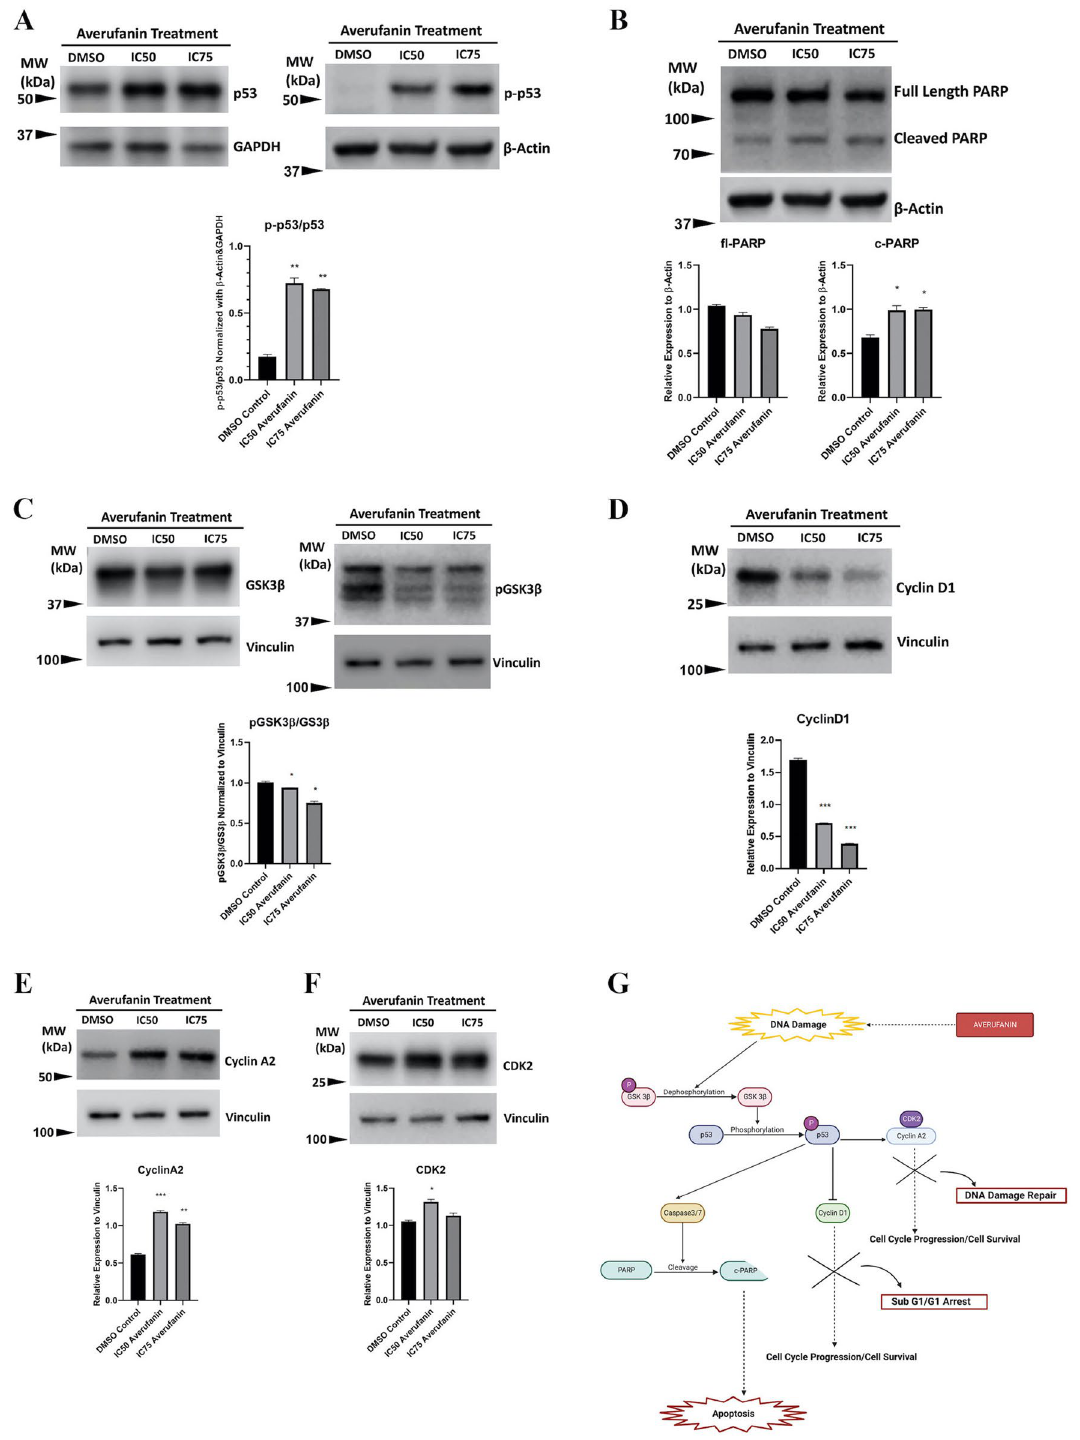
Figure 7. Cellular pathway components targeted by Averufanin treatment. Human breast cancer cells (T47D) were treated with the IC 50 and IC 75 concentrations of Averufanin or DMSO control for 48 h. ( A ) Western blot analysis showed that p53 protein was activated by phosphorylation upon treatment with Averufanin. Furthermore, ( B ) PARP protein was shown to be cleaved indicating induction of apoptosis. ( C ) pGSK3β and ( D ) Cyclin D levels were decreased in correlation with the cell cycle analyses. ( E ) Cyclin A2 and ( F ) CDK2 levels were shown to be increased in correlation with DNA damage response. Original blots are presented in Supplementary Figures. Quantification of the results were obtained using ImageJ software. Graphics and statistical analysis were performed with GraphPad PRISM, DMSO vs Treatment groups and p values are in the brackets. ( G ) Schematic representation of the molecular mechanism of action signaling of the compounds. Blocked pathways are crossed. Multi-step downstream effects are represented with dashed arrows. γ-H2Ax staining results indicated DNA damage caused by the compound, followed by dephosphorylation of pGSK3β and phosphorylation of p53. DNA damage induced activation of tumor suppressor p53 activates Caspase 3/7 pathway followed by PARP cleavage, along with CDK2-Cyclin A2 cell cycle proteins for DNA repair. At the same time Cyclin D1 is inhibited to stop the cell cycle until DNA damage can be repaired. (***p < 0.001 **p < 0.01, *p < 0.05 ns p <